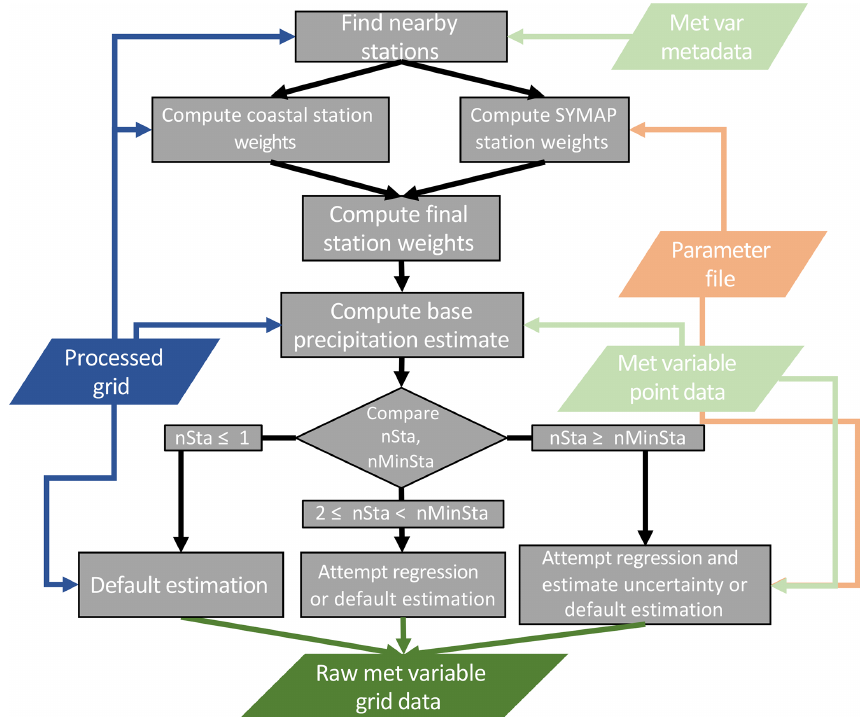
Figure 3. Flowchart describing the precipitation grid point estimate algorithm. Color shading is the same as that in Fig. 1.